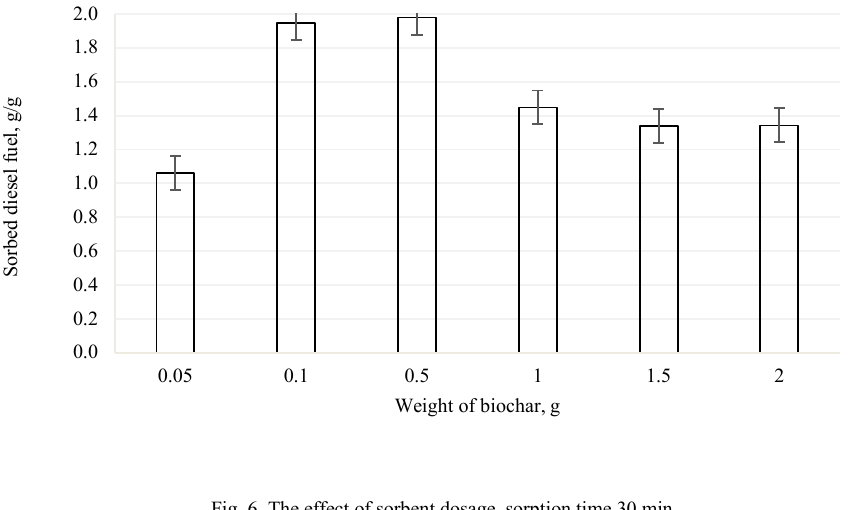
Fig. 6. The effect of sorbent dosage, sorption time 30 min.